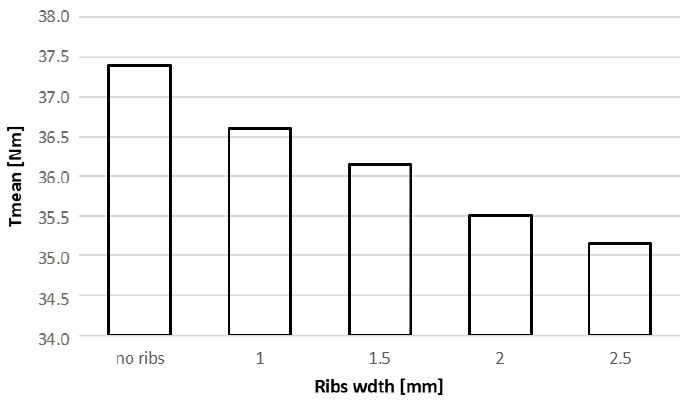
Figure 16. Rib width influence on the mean torque.